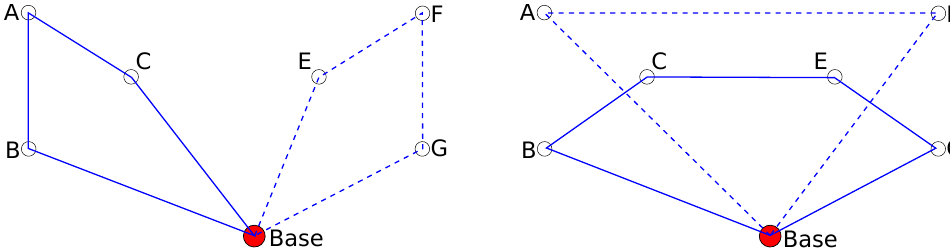
Figure 1. Example of planning alternative trajectories of two unmanned aerial vehicles (UAVs) for a task of covering a set of waypoints (A–G). Two possible solutions are shown for both UAVs (solid and dashed